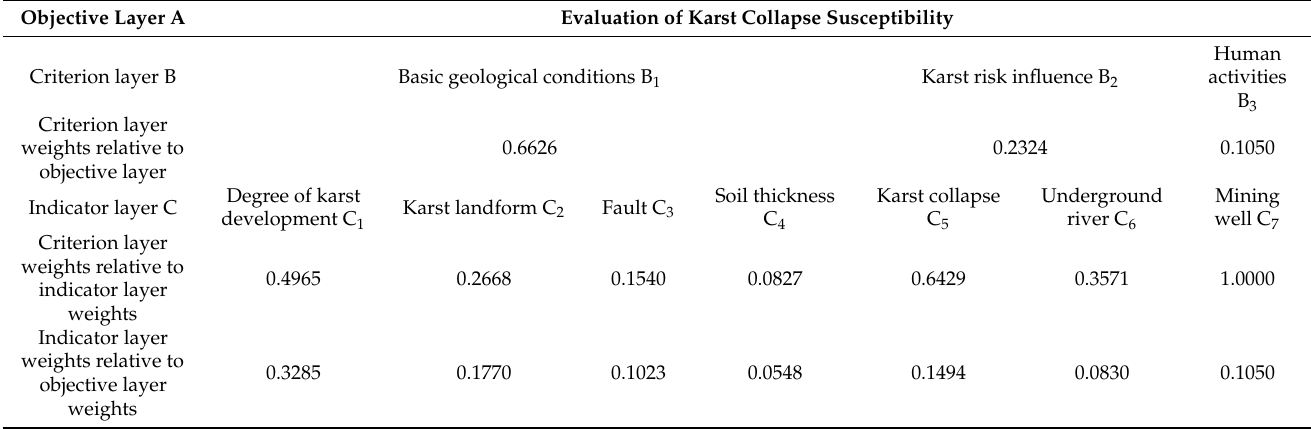
Table 6. Evaluation factor weight allocation